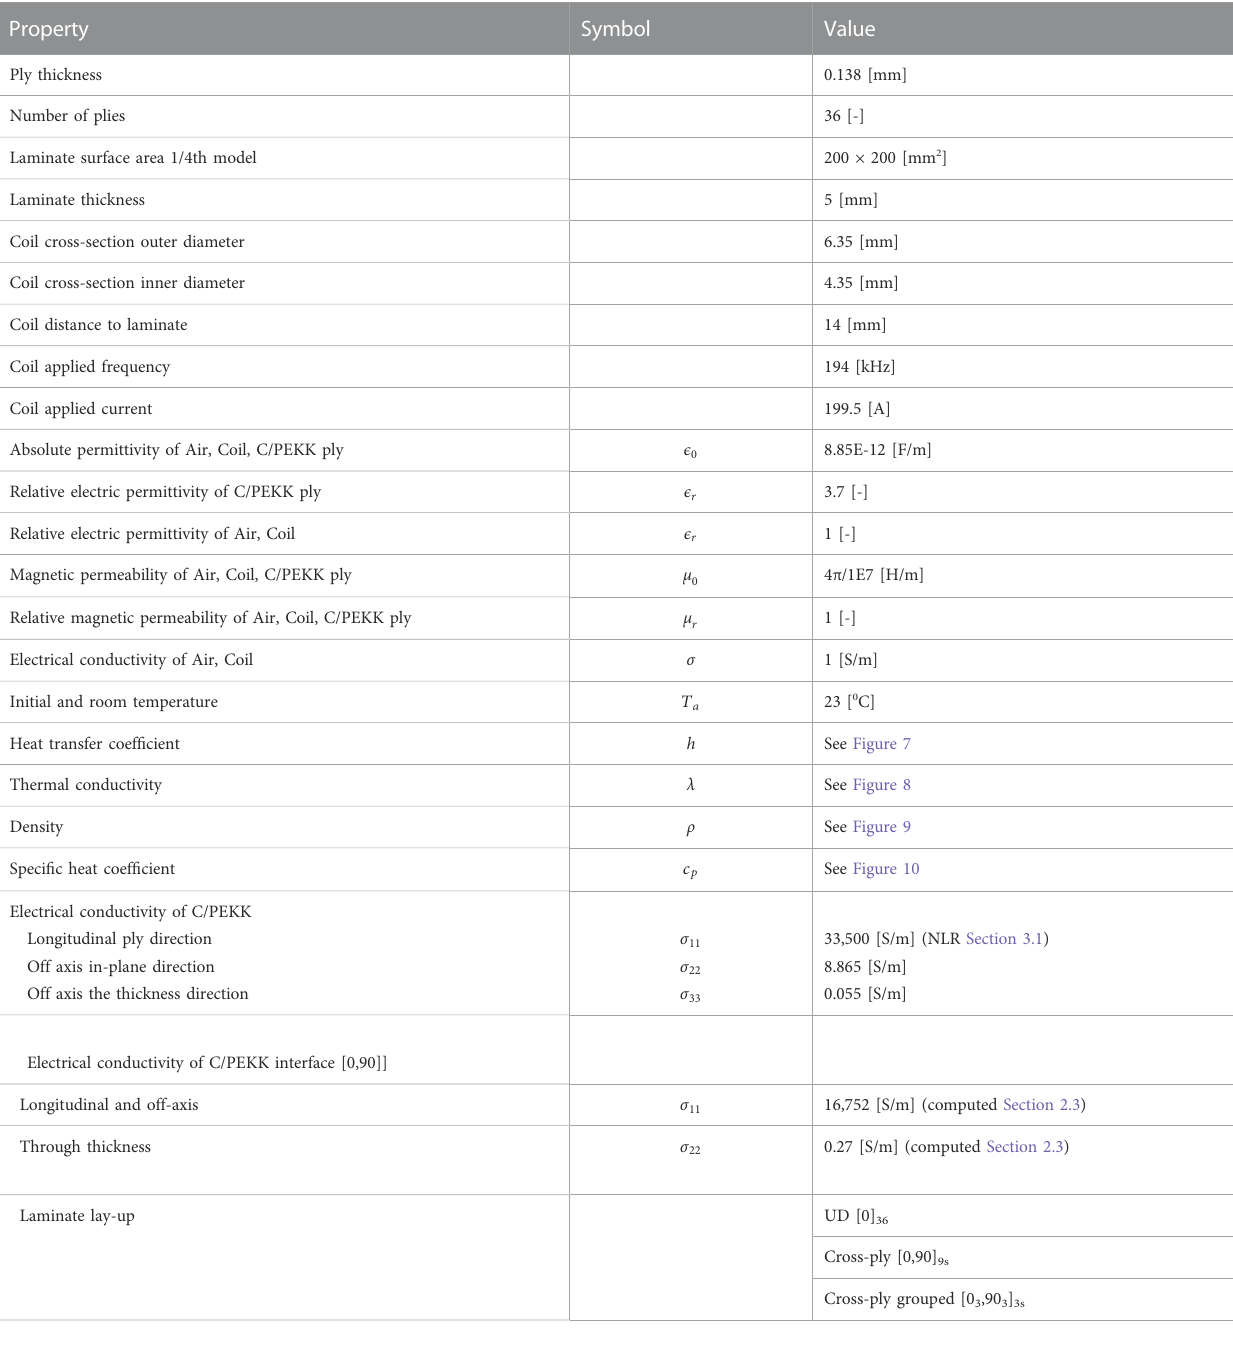
TABLE 1 Material properties for the air, coil and AS4D/PEKK taken from (Grouve, et al., 2020) unless indicated otherwise. Furthermore, dimensions and applied loading that were applied to the model.